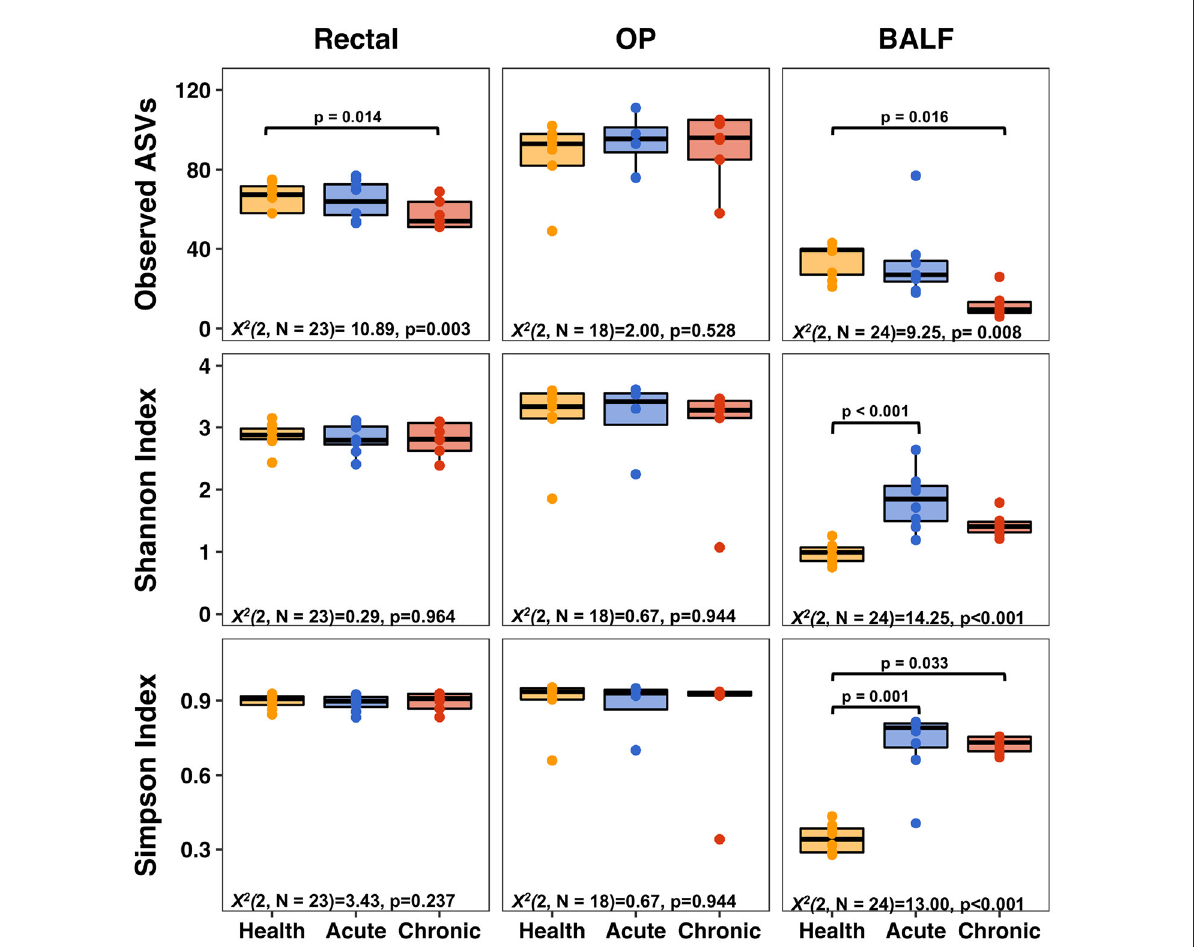
FIGURE1 Alpha diversity metrics—richness (top row), Shannon Index (middle row), and Simpson Index (bottom row) of rectal (left column), upper airways (OP, middle column) and lower airways (BALF, right column). Significant decreases in richness were observed in BALF and rectal samples when comparing health to chronic asthma. Within sample diversity in BALF was significantly increased in acute and chronic asthma. OP, oropharyngeal; BALF, bronchoalveolar lavage